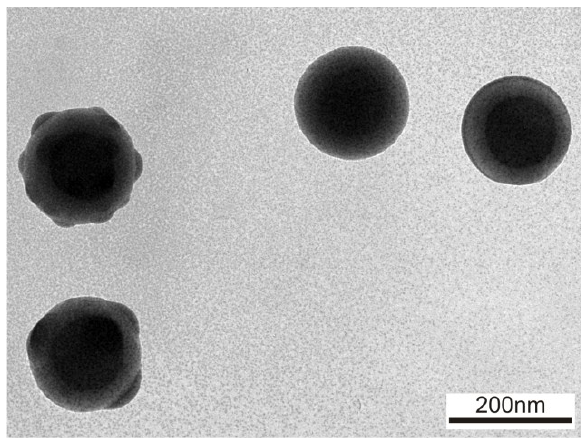
Figure A3. TEM image of commercially available silica particles used without further treatment and coated with molybdenum oxide. The picture shows different morphologies of the coating, likely due to irregular residues on the particle surface, which hinder conformal